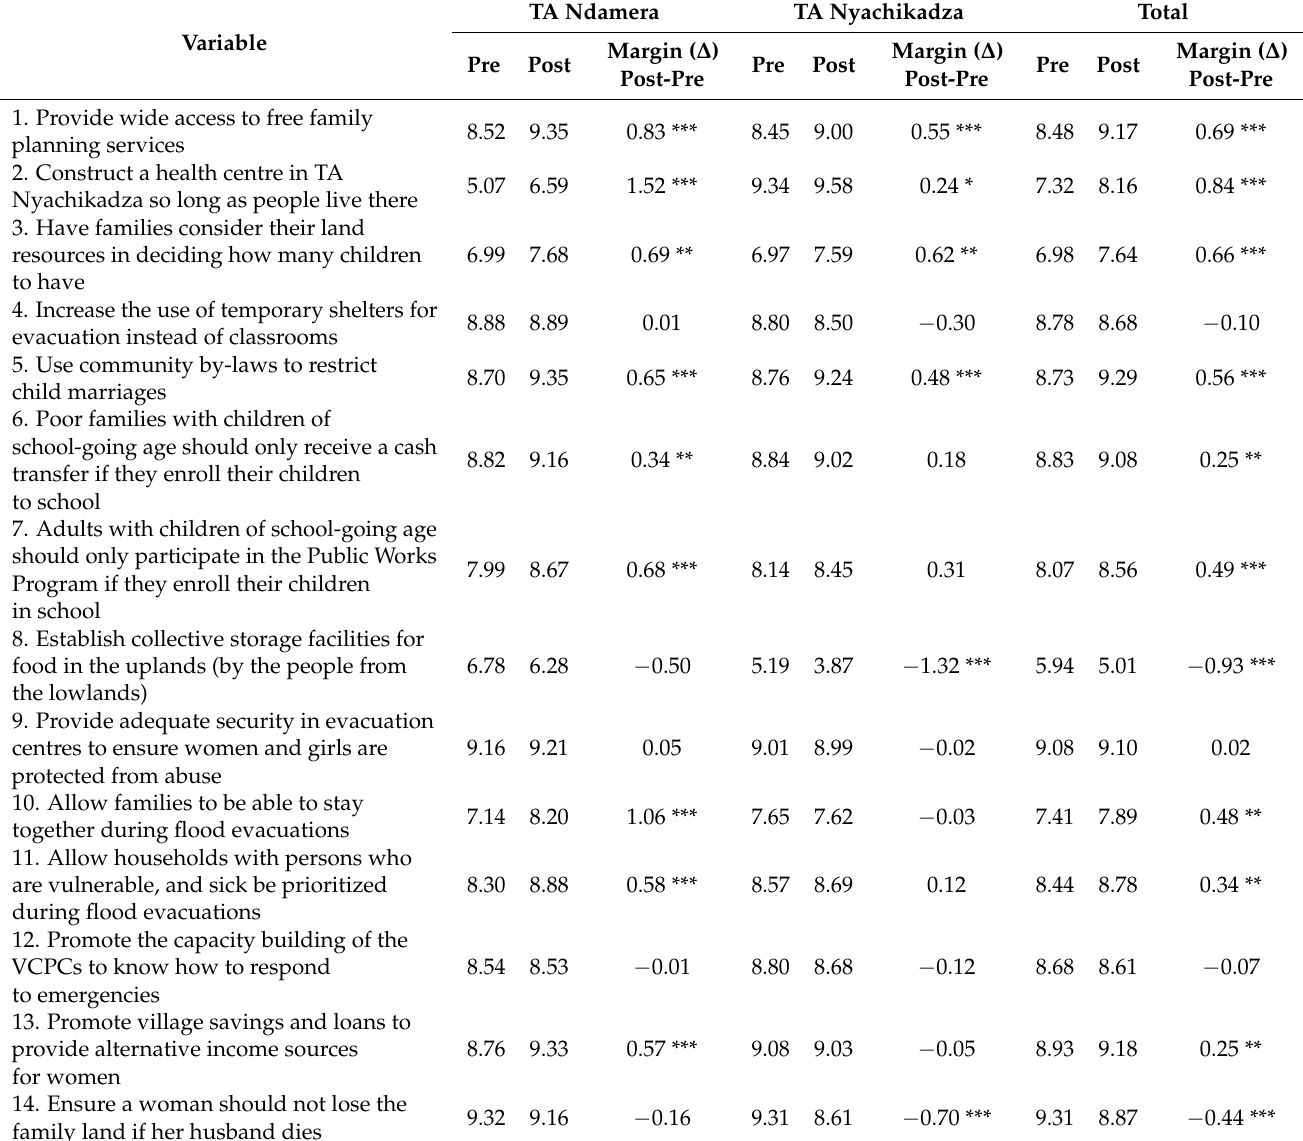
Table 4. What the government should do regarding population pressure, gender, and social services.